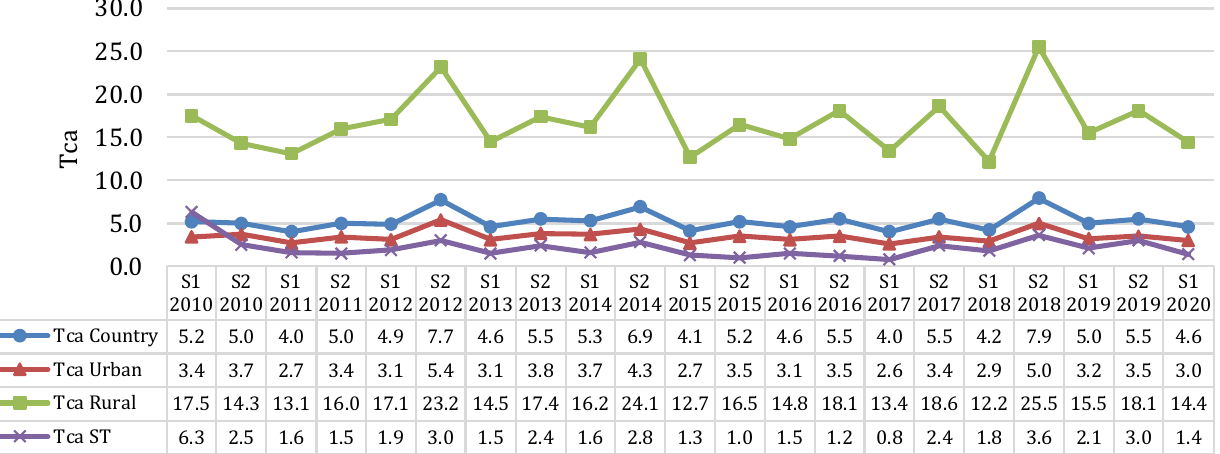
Figure 7. Semiannual Tc a from Uruguay from 2010 to